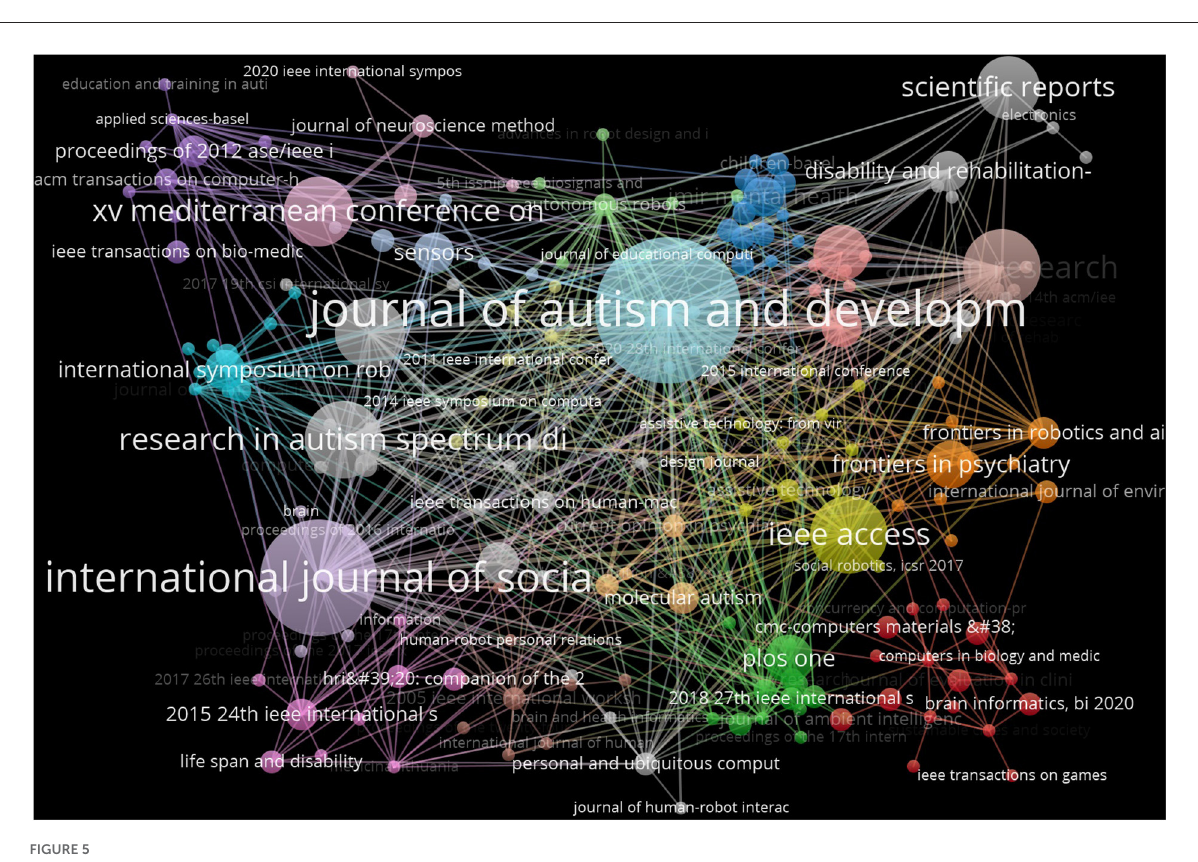
FIGURE5 The citation network of journals related to Al on